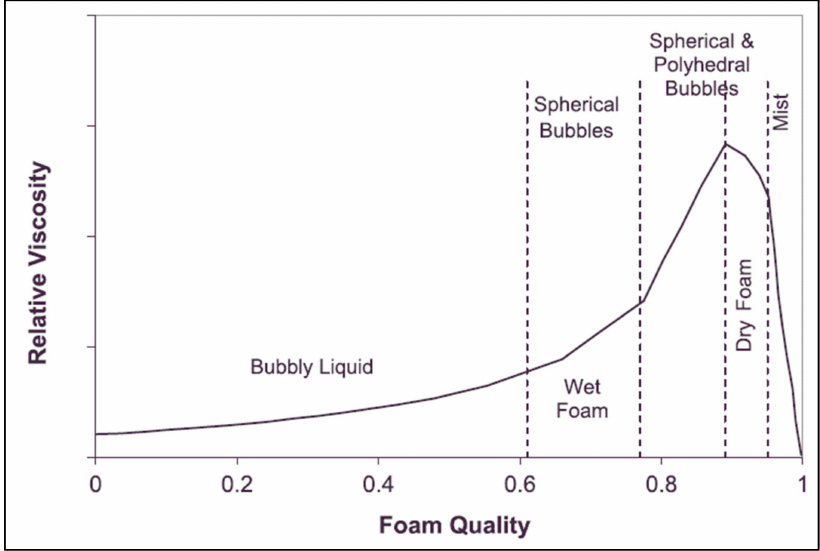
Figure 12. The relationship between foam quality to foam relative viscosity (Reprinted with the permission from Sinha et al. [51]). Copyright 2019, Elsevier